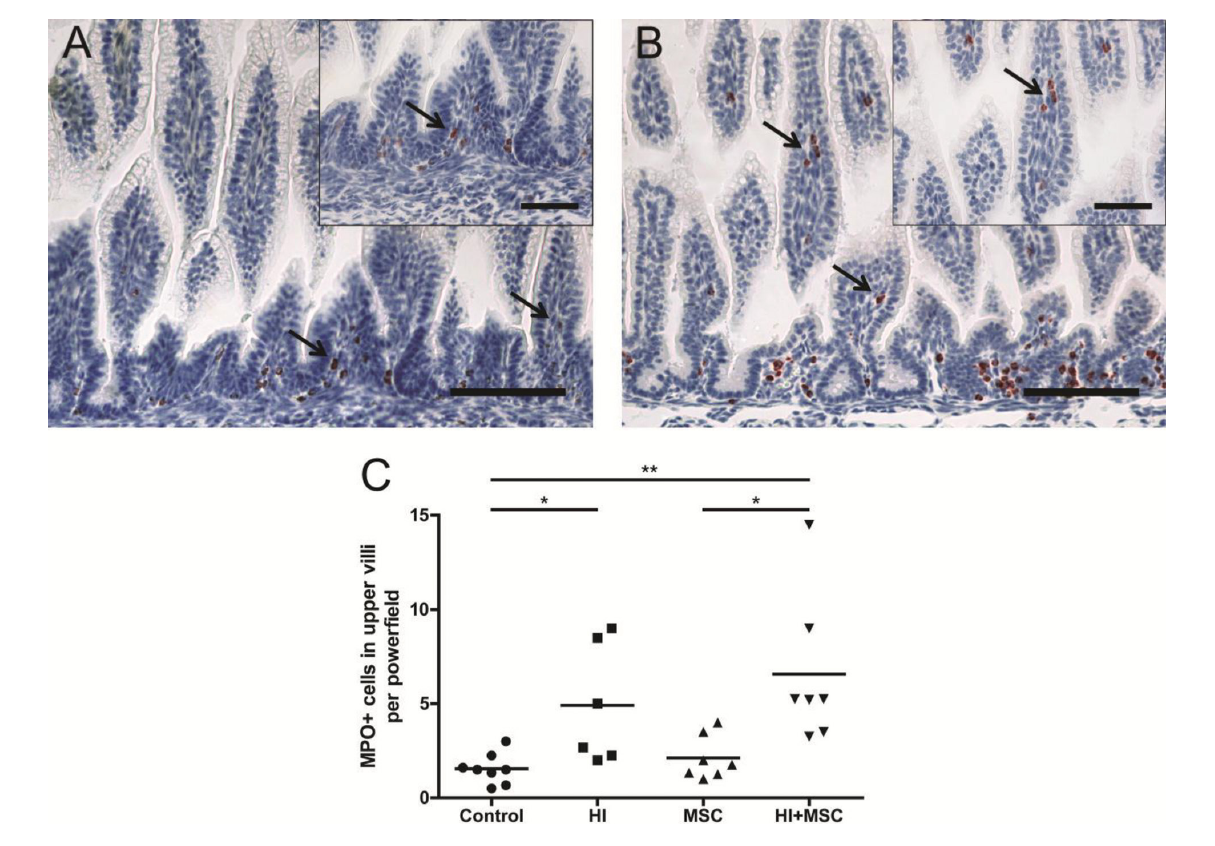
figure 2. Increased number of MPO + cells in the upper part of the villi 7 d after HI. Representative intestinal sections of (A) control and (B) HI animals were stained by immunohistochemistry for MPO. For each experimental group, MPO + cells (arrows) in the upper part of the villi were counted, and the mean cell counts per power field per animal are given (C). The scale bar in panels A and B represents 100 μ m. The scale bar in insets represents 50 μ m. * p < 0.05, ** p <